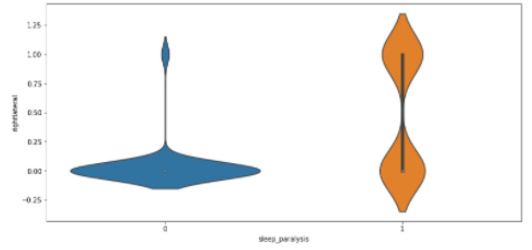
Figure 18. SVM Confusion Matrix with Linear Kernel